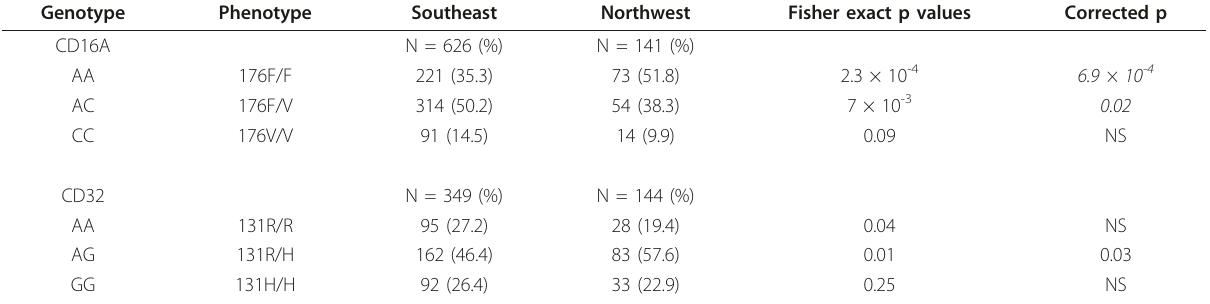
Table 2 Distribution of rs396991 (CD16A) and rs1801274 (CD32) genotypes and phenotypes in controls subjects from southeast and northwest populations